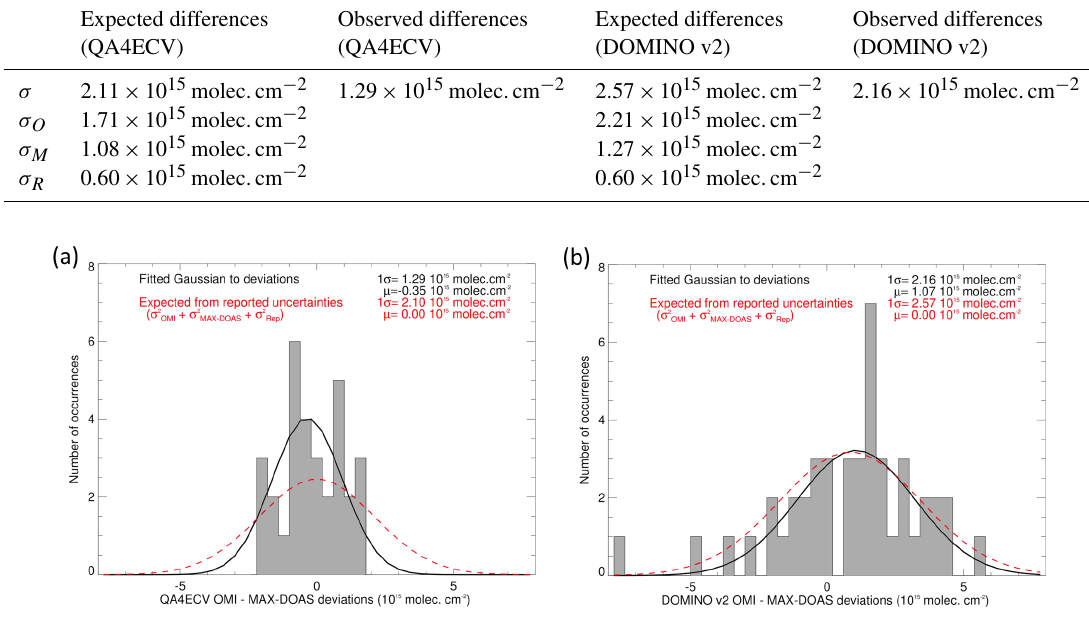
Figure 13. (a) Histogram of differences in QA4ECV OMI vs. MAX-DOAS tropospheric NO 2 columns for Tai’an (China) in May–June 2006. The black line shows a Gaussian fit to the observed differences, and the red dashed lines shows the Gaussian expected from the uncertainties reported in the QA4ECV and MAX-DOAS data products. (b) Same as (a) , but now for differences between DOMINO v2 and MAX-DOAS tropospheric NO 2